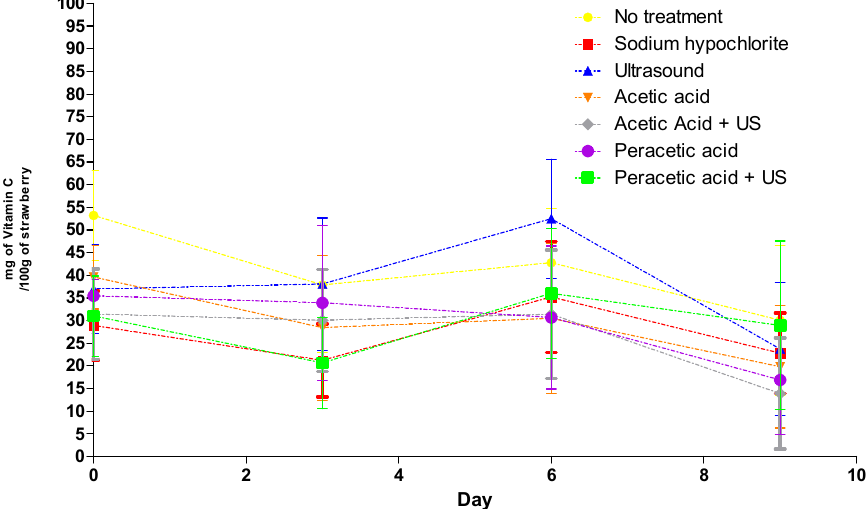
Figure 2. Mean variation of vitamin C analyzed in strawberries from all treatments and control during 9 d of storage. Linear and quadratic models were tested to explain the behavior of the analyzed var- iables as a function of time; however, it was not possible to remove significant adjustment and obtain significant regression models. Thus, the variables were plotted to visualize their behavior. After the treatments were applied to the samples on the first day, the vita-